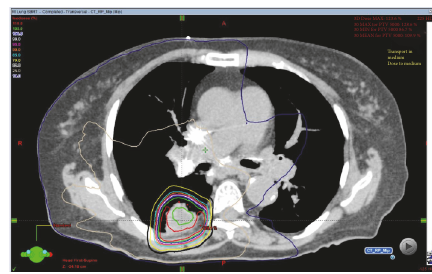
Figure 1: SBRT plan for Patient 1 showing conformal radiation dose delivery to the right pulmonary mass.